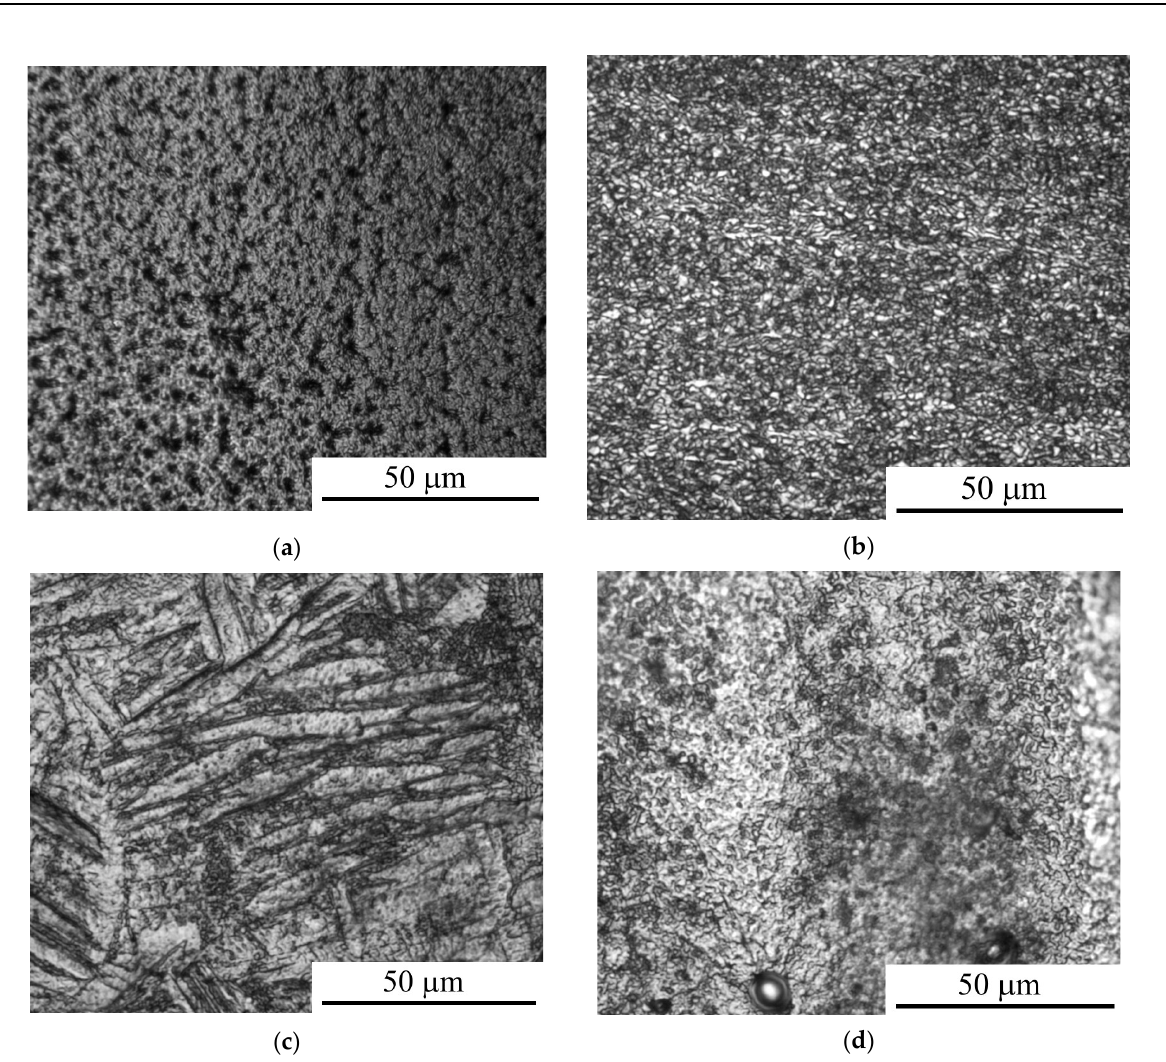
Figure 6. Morphology of the CP-Ti surface after PENC at 900 °C ( a ) and subsequent PEP in a solution of ammonium fluoride (4%) during 5 min at different voltage: ( b ) 275 V; ( c ) 300 V; ( d ) 325 V.